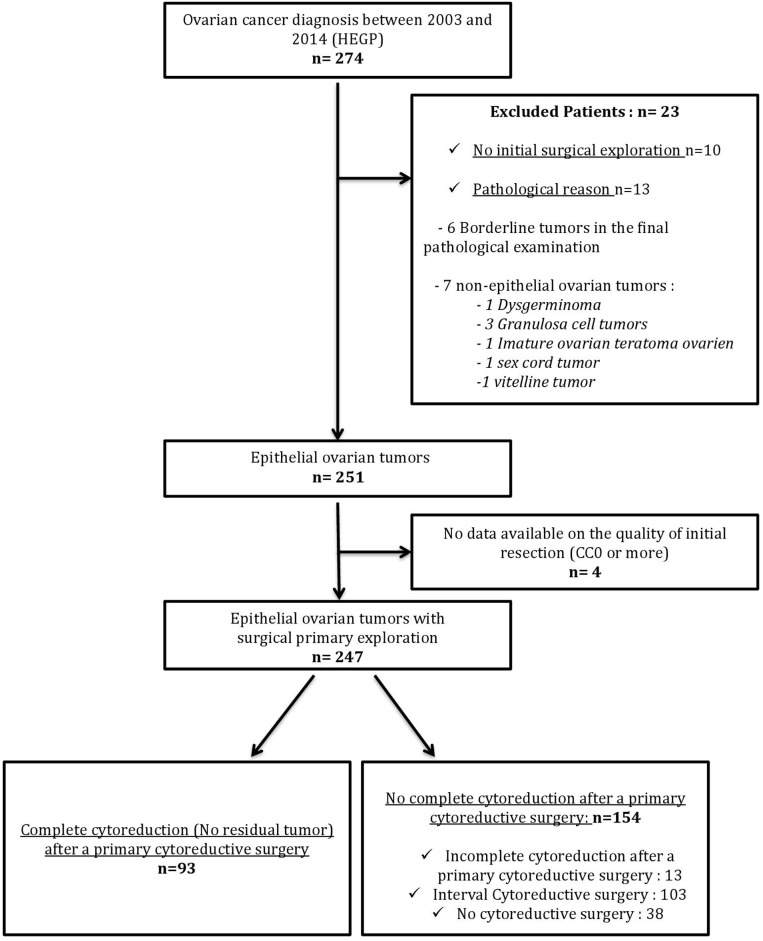
Flow chart for the derivation population.HEGP, Hôpital Européen Georges Pompidou.